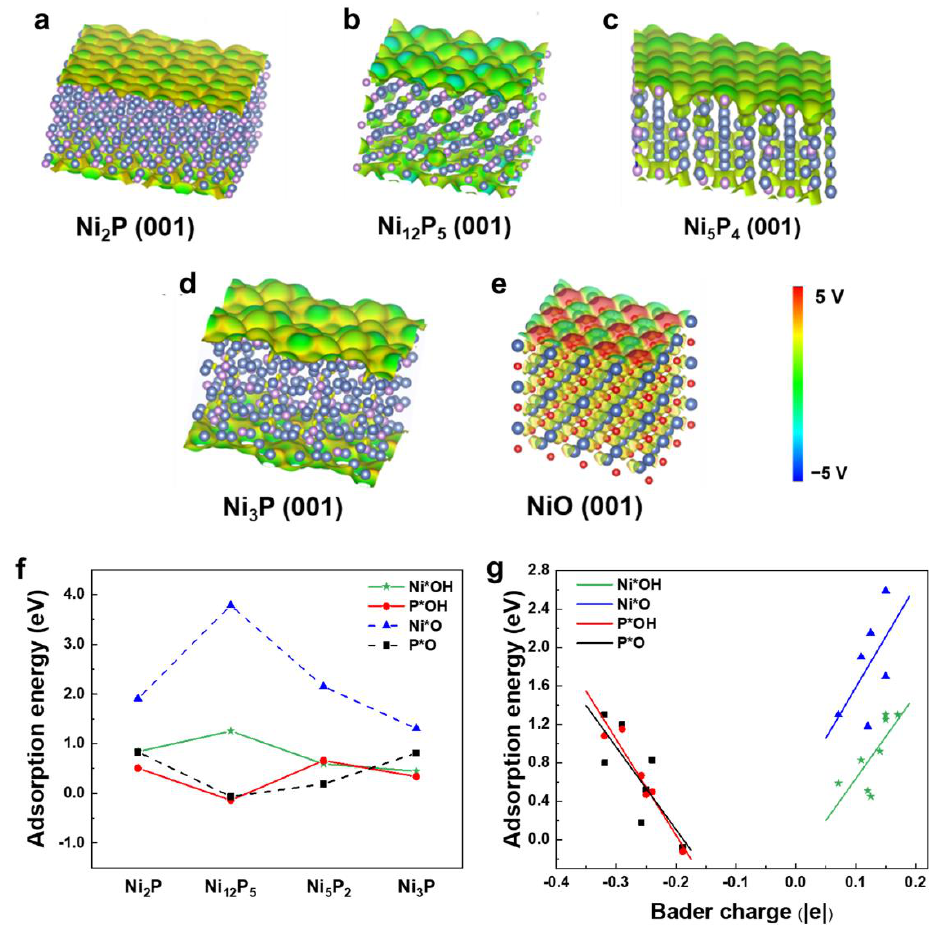
Figure 4. Surface electrostatic potential: ( a ) Ni 2 P (001), ( b ) Ni 12 P 5 (001), ( c ) Ni 5 P 2 (001), ( d ) Ni 3 P (001), and ( e ) NiO (001). The isosurface value is set to 0.2 e/Å 3 . ( f ) Adsorption energies of OH and O adsorbents on the surfaces of Ni 2 P (001), Ni 12 P 5 (001), Ni 5 P 2 (001), and Ni 3 P (001). ( g ) The relationship between adsorption energy (OH and O) and Bader charge of the atom (Ni or P) bonded with adsorbents.